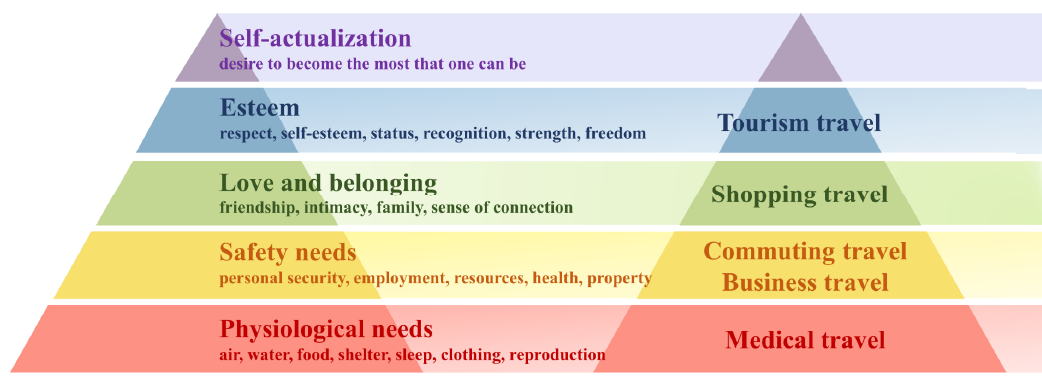
Figure 13. Classification of residential travel according to Maslow’s hierarchy of needs.